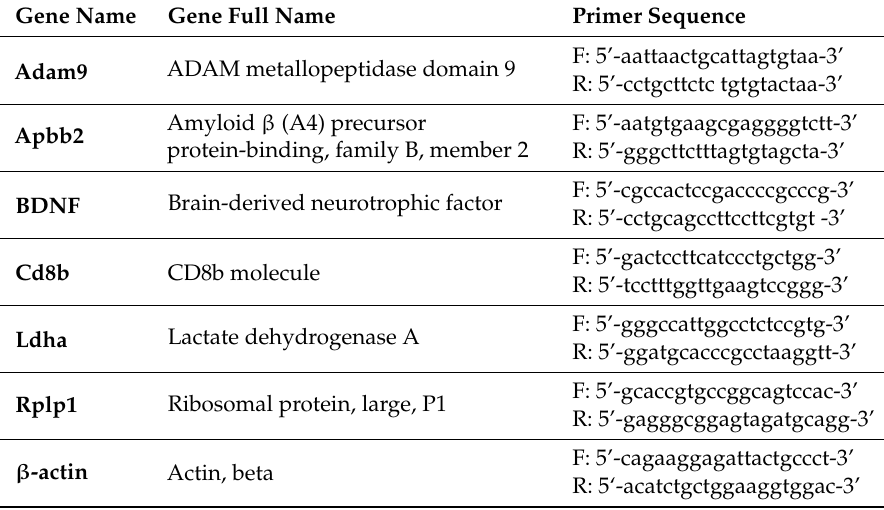
Table A1. Primer